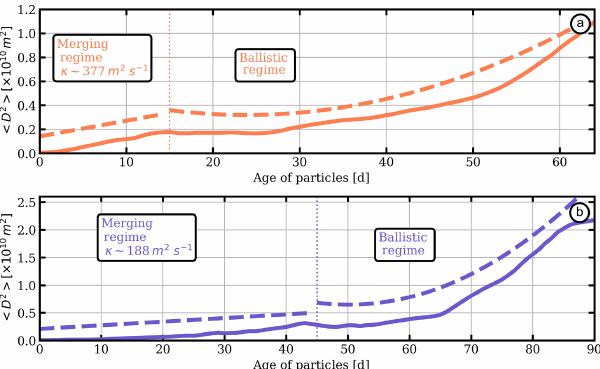
Figure 10. (a, b) Time evolution of the mean square distance be- tween particles and their center of mass with regard to the subme- soscale cyclone and anticyclone, respectively (solid lines). Fits of merging and ballistic regimes are shown in dashed lines.